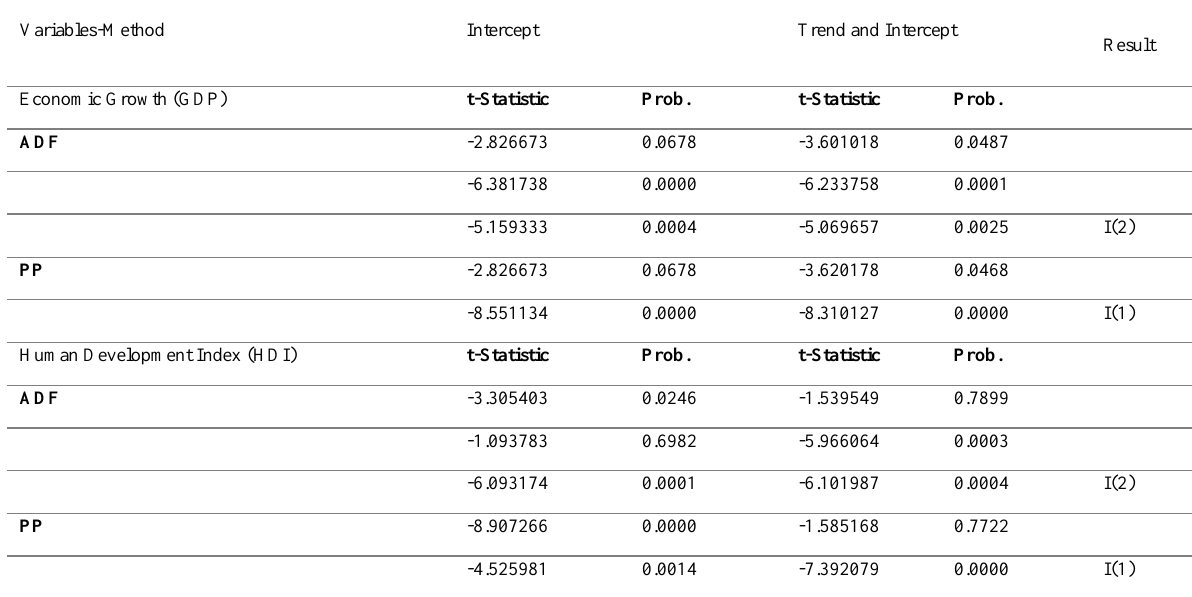
Table 7: ADF ve PP Unit Root